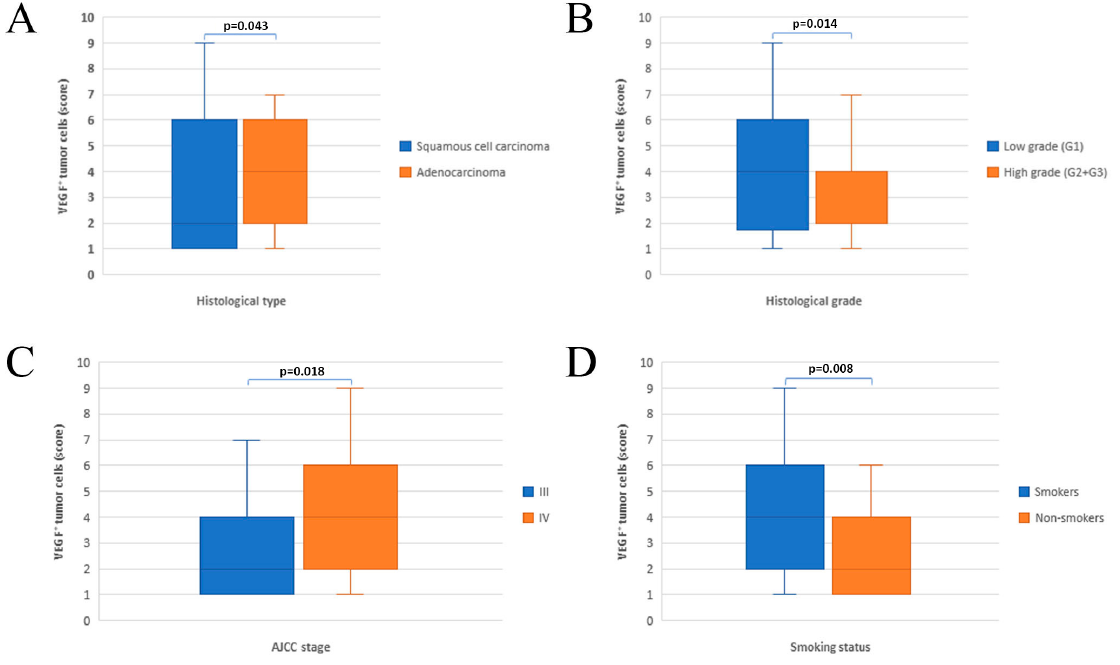
Figure 2. Assotiation between the IHC expression of VEGF and clinicopathiological features ( A )